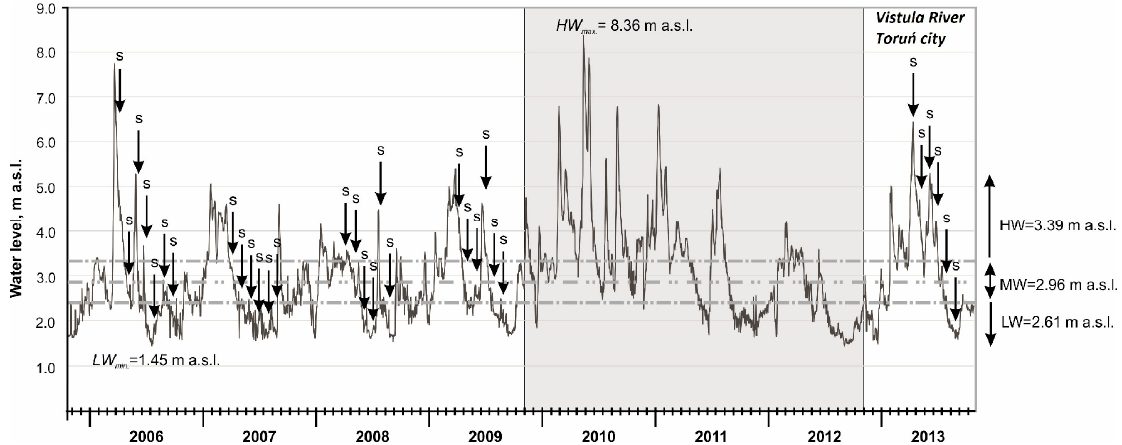
Figure 2. Hydrograph of the lower Vistula River from the gauge station in Toru ń . HW max —the maximum water level, LW min —the lowest water level. HW—average of high water levels, MW—average of mean water levels, LW—average of low water levels have been calculated from the study period 2006–2009 and 2013 (grey area indicates a period without sampling). Arrows with “s” indicate sampling times.